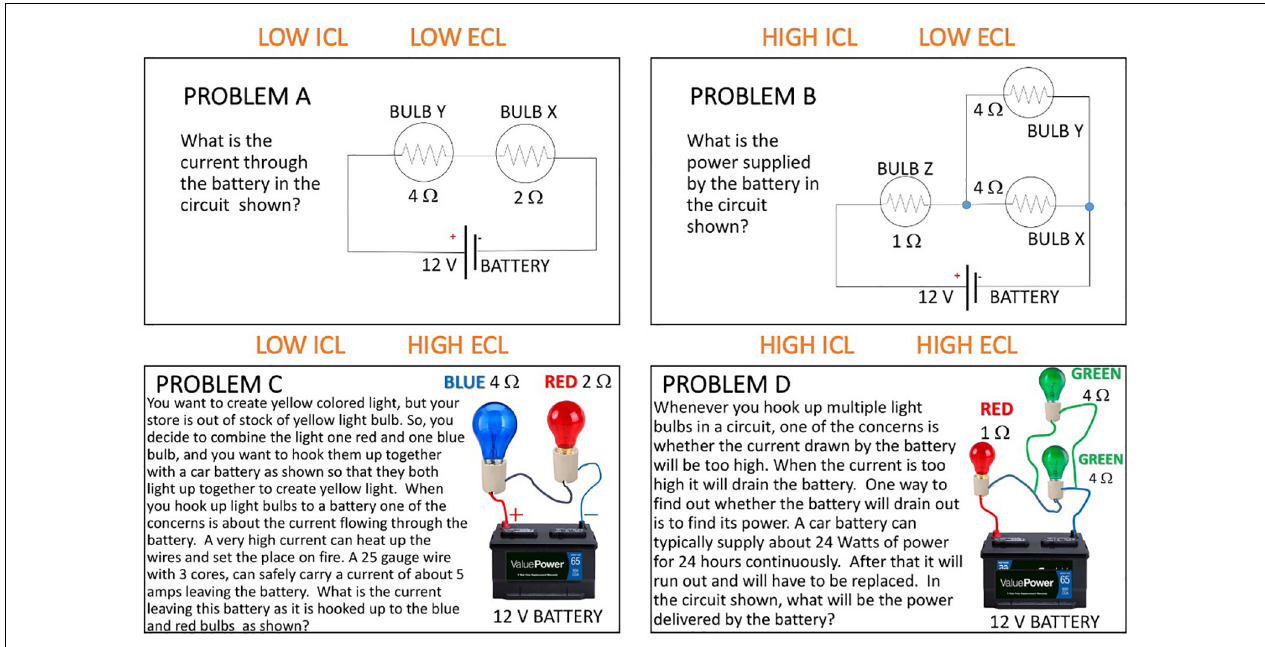
FIGURE 1 | Problems solved and compared by participants and their respective ICL and ECL